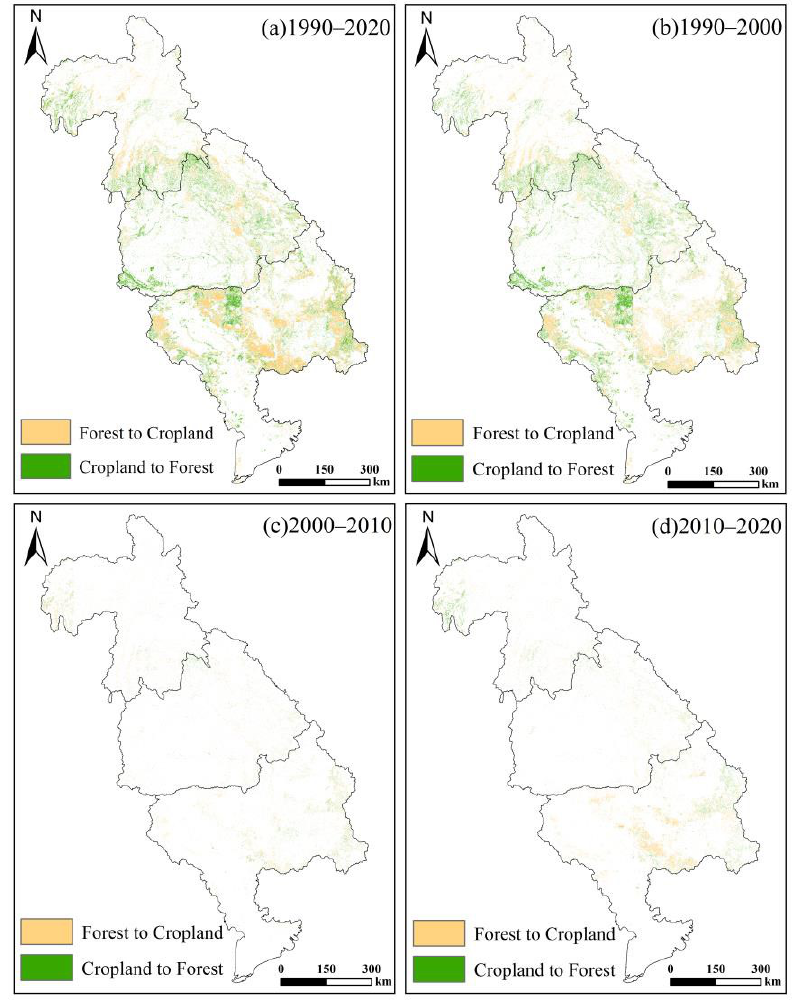
Figure 4. Spatial distributions of the conflicts between cropland and forest in the Mekong River Basin (MRB) during ( a ) 1990–2020, ( b ) 1990–2000, ( c ) 2000–2010, and ( d ) 2010–2020. We also found that the conflicts between cropland and forest varied greatly among different elevations in the MRB in the last 31 years (Figure 5a). Specifically, about 60.0% and 23.1% of the CEFL occurred in the plains and hills, respectively. During 1990–2000, 61.4% of the CEFL was in the plains below 200 m. Then, although the scale of CEFL was decreasing during 2000–2010, the corresponding proportion of changes in the plains was still close to half (49.5%). Since 2010, about 68.8% of CEFL was located in the plains. This indicates that the forests in the plains were preferentially cut down and reclaimed as cropland. By contrast, CFFR obviously tend to be in areas with higher elevations that are unsuitable for cultivation. The proportion of CFFR in the plains decreased from 56.8% during 1990–2000 to 38.9% during 2010–2020, while the proportion increased from 11.4% to 30.2% in the low and middle mountains. It should be emphasized that the plains of the MRB account for the highest proportion of total land area, which is greater than the sum of the areas of other terrains. This further indicated that CFFR tends to occur in the